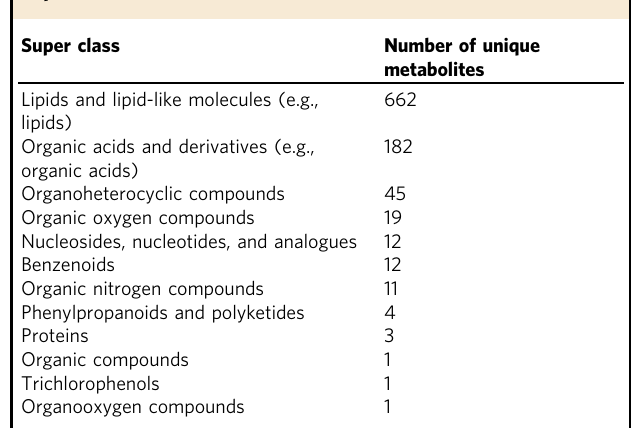
Table 1 Overview of the number of unique metabolites per super